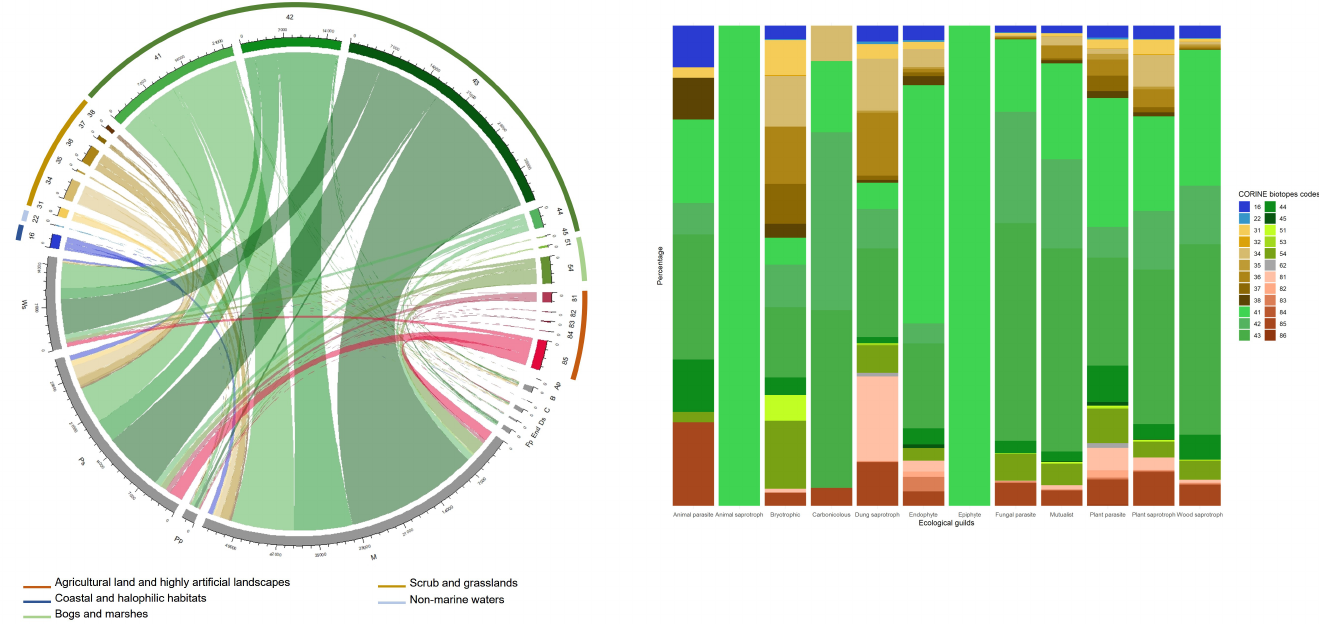
Figure 8. ( A ) Distribution of the functional diversity of fungal taxa recorded in FongiBase and the habitats of collecting. The typology of ecological guilds is based on FunGuild and includes 12 concatenated types: Animal parasites (Ap), Animal saprotrophs (As), Bryotrophic (B), Carboni- colous (C), Dung saprotrophs (Ds) Endophytes (End), Epiphytes (X), Fungal parasites (Fp), Mycor- rhizal (M), Plant parasites (Pp), Plant saprotrophs (Ps) and Wood saprotrophs (Ws). The typology of habitats is based on CORINE biotope codification. All records which could be unambiguously assigned with confidence to one of the following CORINE codes are represented. 16: Coastal sand-dunes and sand beaches, 22: Standing fresh water, 31: Heath and scrub, 32: Sclerophyllous scrub, 34: Dry calcareous grasslands and steppes, 35: Dry siliceous grasslands, 36: Alpine and subalpine grasslands, 37: Humid grasslands and tall herb communities, 41: Broad-leaved deciduous forests, 42: Coniferous woodland, 43: Mixed woodland, 44: Alluvial and very wet forests and brush, 45: Broad-leaved evergreen woodland, 51: Raised bogs, 53: Water-fringe vegetation, 54: Fens, tran- sition mires and springs, 62: Inland cliffs and exposed rocks, 81: Improved grasslands, 82: Crops, 83: Orchards, groves and tree plantations, 84: Tree lines, hedges, small woods, bocage, parkland dehesas, 85: Urban parks and large gardens, 86: Towns, villages, industrial sites. ( B ) Relationship between the fungal ecological guilds and CORINE biotopes